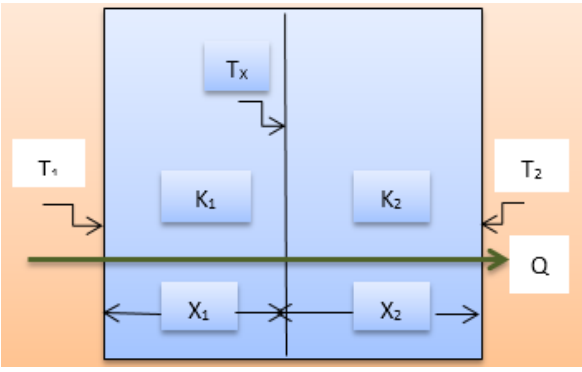
Figure 1: Heat flow through a double